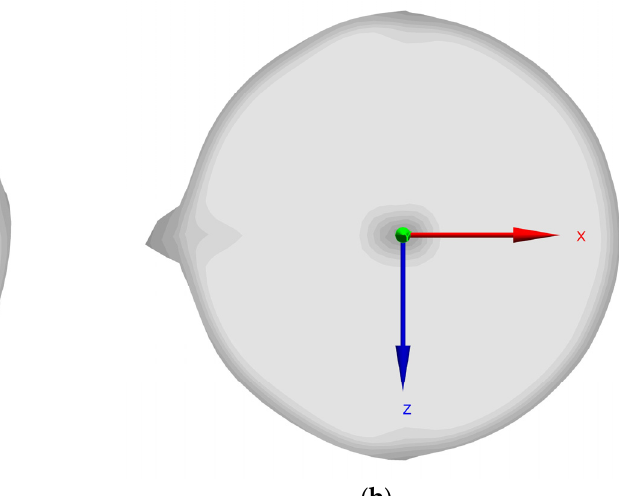
Table 5. Comparison of the swirl numbers for the distributor.